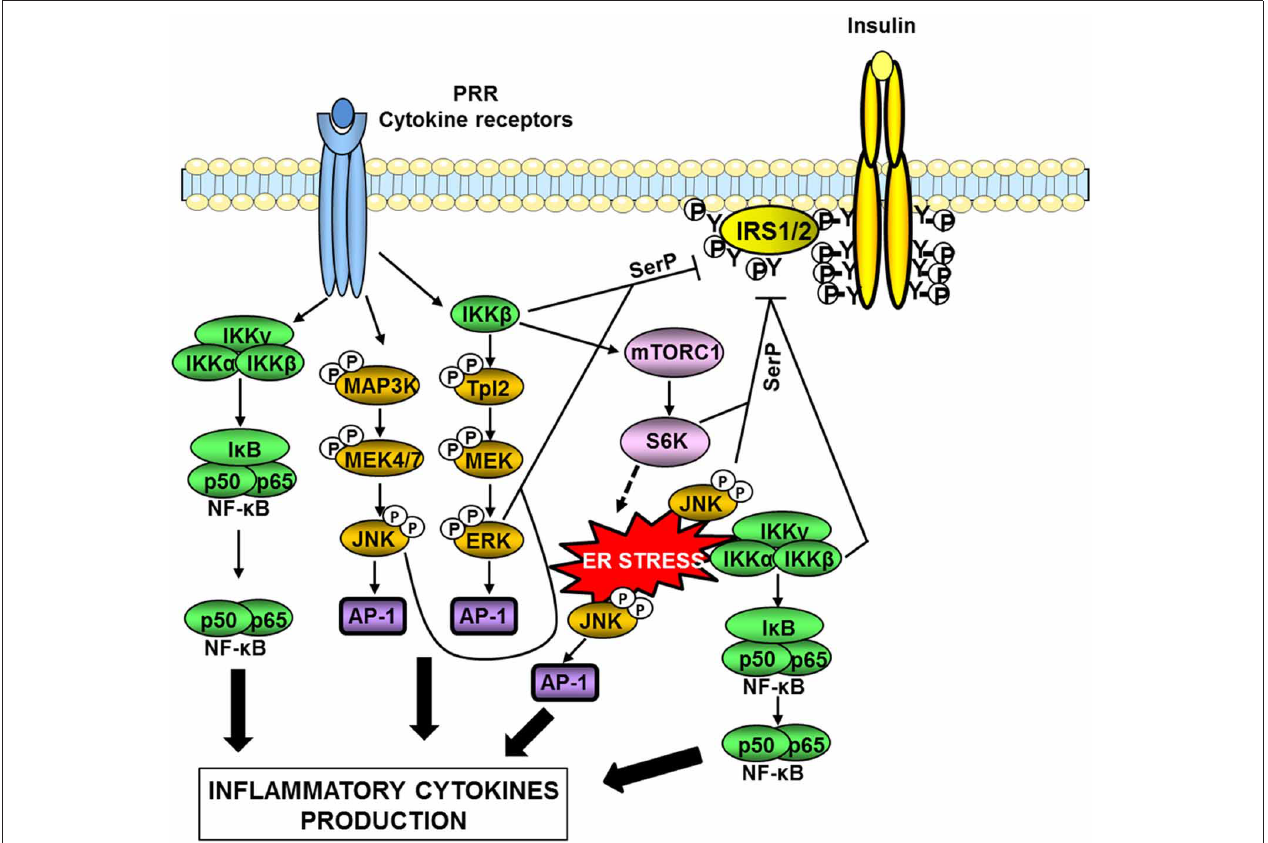
FIGURE 3 | Serine kinases involved in obesity-induced inflammation and insulin resistance. In obesity, a network of serine kinases is activated including IKK β , JNK, and ERK1/2. JNK and IKK β are activated downstream of pattern-recognition receptors (PRRs) such as TLRs or by ER stress. IKK β is also involved in the activation of the Tpl2/ERK pathway. These pathways participate in the production of inflammatory cytokines via the transcription factors AP-1 and NF- κ B. Many of the produced inflammatory